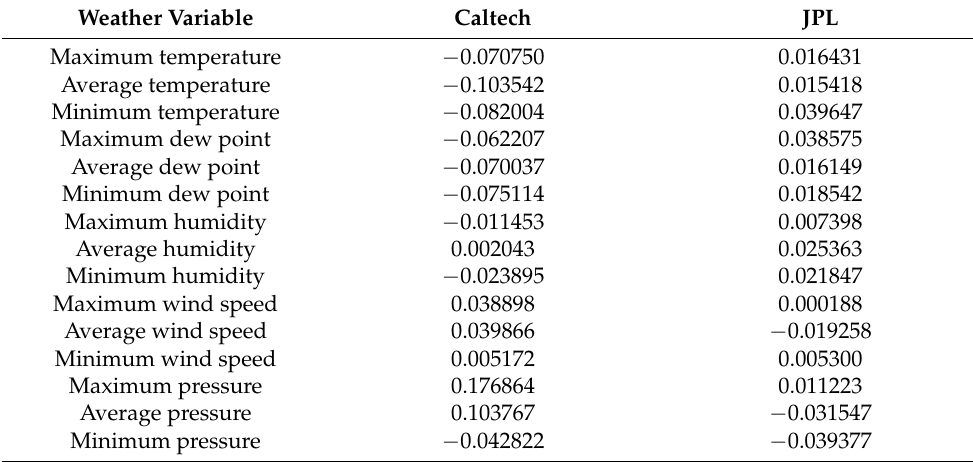
Table 2. Correlation scores of weather variables with power